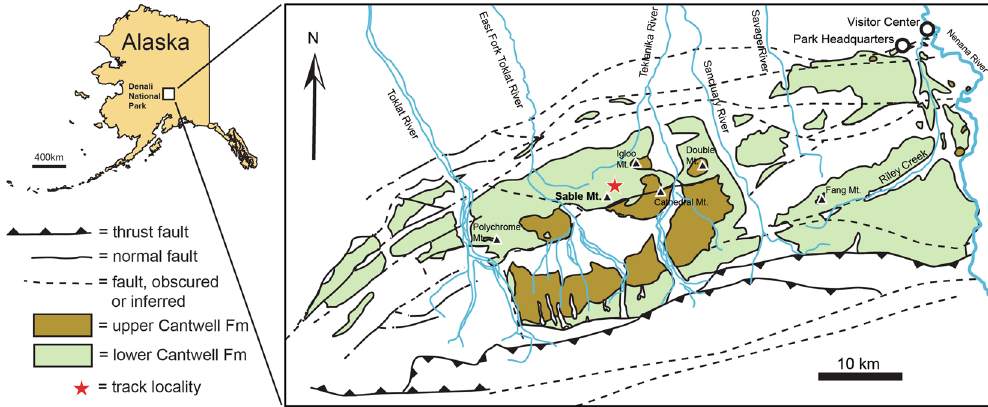
Figure 1. Map of Alaska and the Cantwell Formation within Denali National Park and Preserve. Star signifies study area. This map was drafted by R.S.T. in Adobe Illustrator, CC2017. (www.adobe.com/products/illustrator. html).